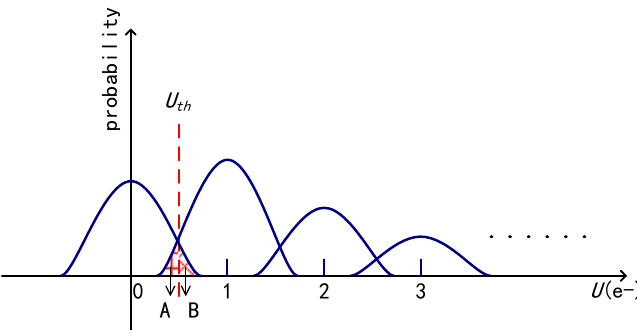
Figure 2. A readout signal of a single-bit quanta image sensor (QIS).